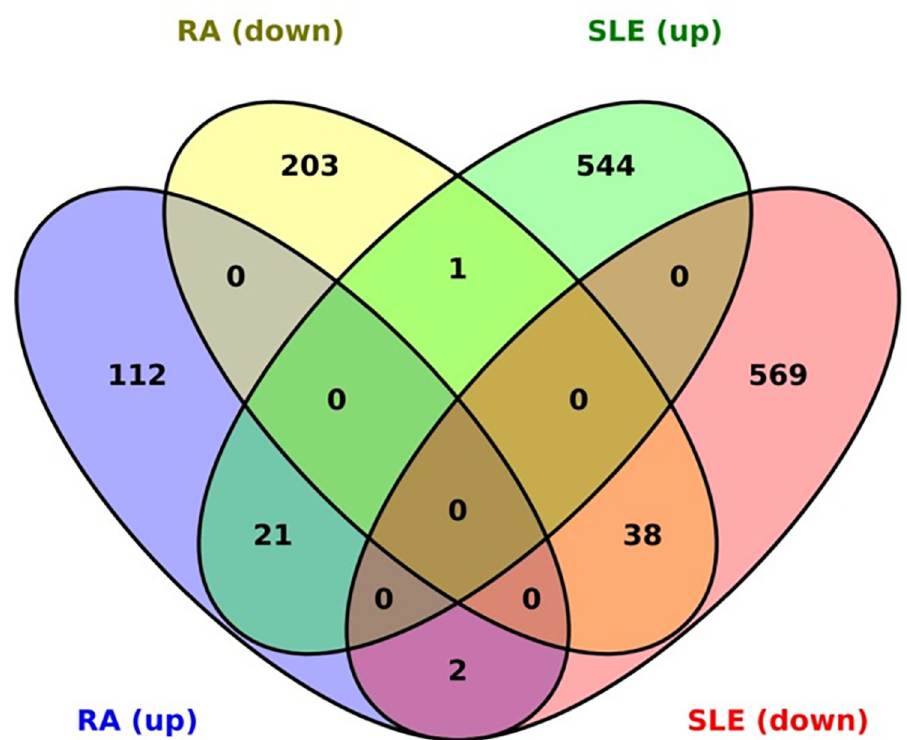
Fig 3. Venn diagram of DEGs. Comparison of DEGs (both upregulated and downregulated) obtained from individual meta-analyses of RA and SLE. The intersection showed the genes common to both diseases.